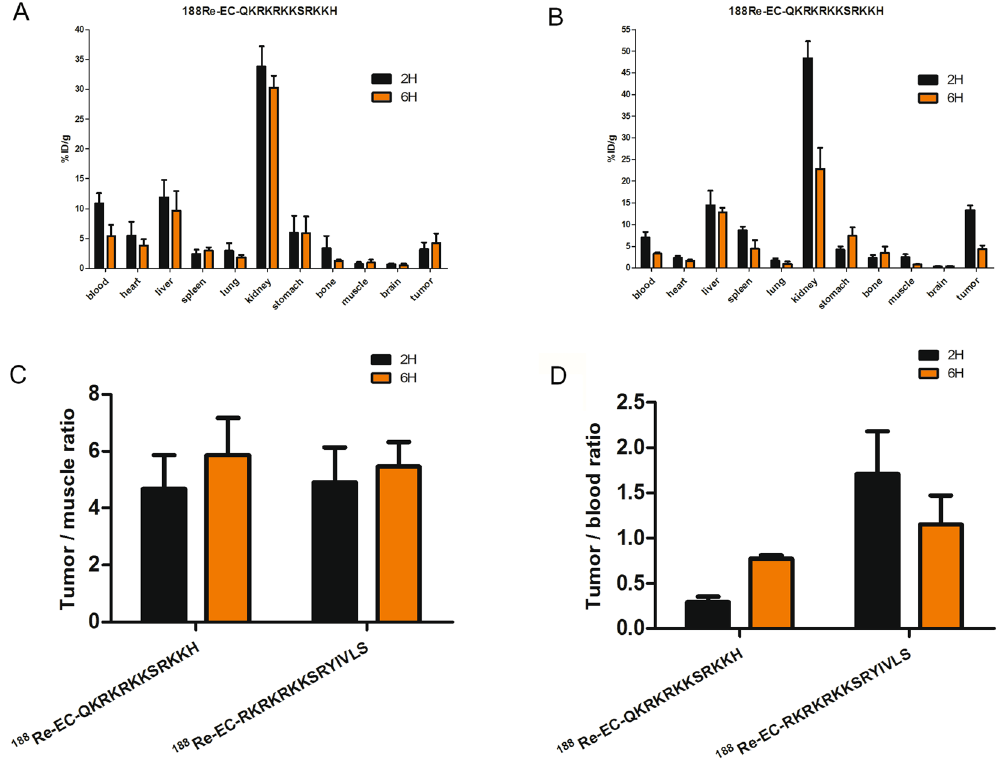
Figure 6. Biodistribution of 188 Re-labeled peptide in A549 tumours. A549 tumor bearing mice received 7.4 MBq 188 Re-labeled peptide (n = 12) intravenously. Ex vivo biodistribution at 2 and 6 h after injection of 188 Re- labeled peptide are shown in figure ( A , B ). Tumor/muscle ratio ( C ) and Tumor/blood ratio ( D ) were calculated.